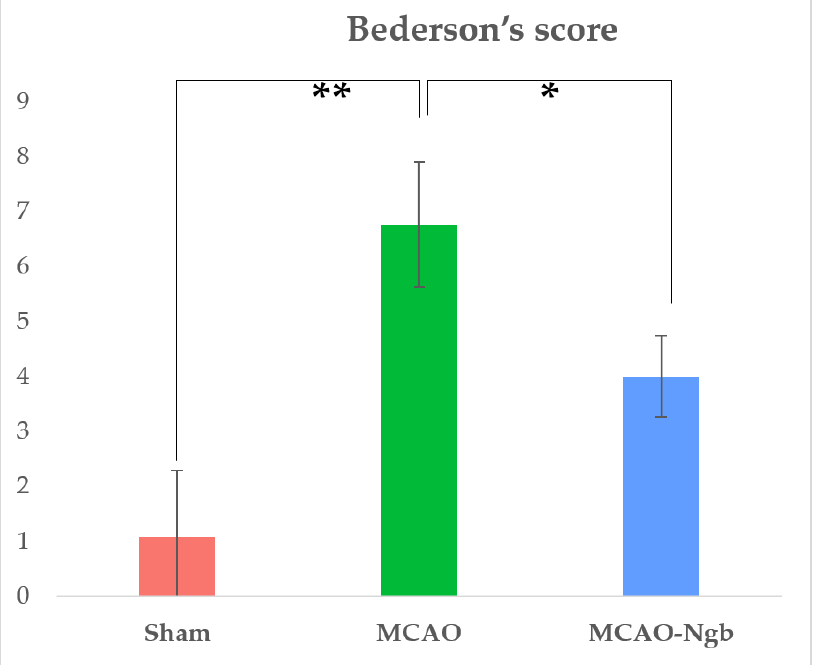
Figure 2. Results of Bederson’s score performed in sham ( n = 22), MCAO ( n = 22), and MCAO-Ngb ( n = 20) groups after 24 h of reperfusion, and immediately before sacrifice. Data are average values of five experimental animals in each group (* p < 0.05; ** p < 0.01).